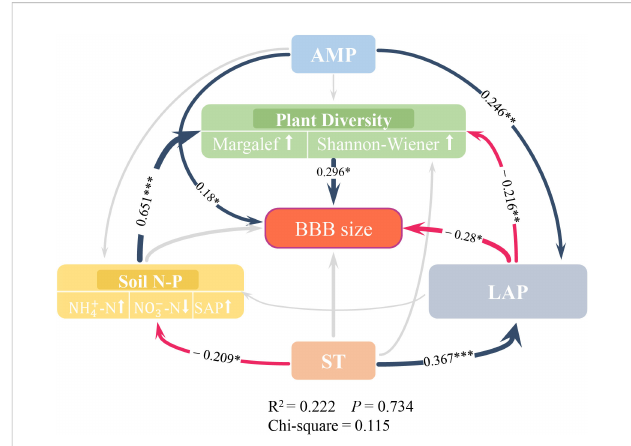
FIGURE 4 Structural Equation Modeling of belowground bud bank and environmental factors. Direct and indirect impacts of key factors on belowground bud bank size. The colored arrows and gray arrows represent signi fi cant and non-signi fi cant relationships, respectively (* p <0.05, ** p <0.01 and *** p <0.001, only the values of path coef fi cients with signi fi cance were presented in SEM); Positive correlations are displayed in dark blue arrows, and negative correlations are displayed in red arrows; The arrows thickness represent the values of path coef fi cients. The thicker the path, the bigger the value. Of note, the variables in the double-layer rectangles represent the screened factors (results of BRT analysis in Figure 2) that were used in PCA, and arrows pointing up or down in double-layer rectangles represent the positive or negative relationships between the observed variables and potential variables. The environmental factors from top to bottom are AMP (annual mean precipitation), Plant Diversity (Margalef [Margalef index], Shannon_Wiener [Shannon-Wiener index]), BBB (belowground bud bank), Soil N-P (NH 4+ -N [soil ammonium nitrogen], NO 3 − -N [soil nitrate nitrogen], SAP [soil available phosphorus content]), LAP (soil leucine aminopeptidase, EC:3.4.11.1), ST (soil